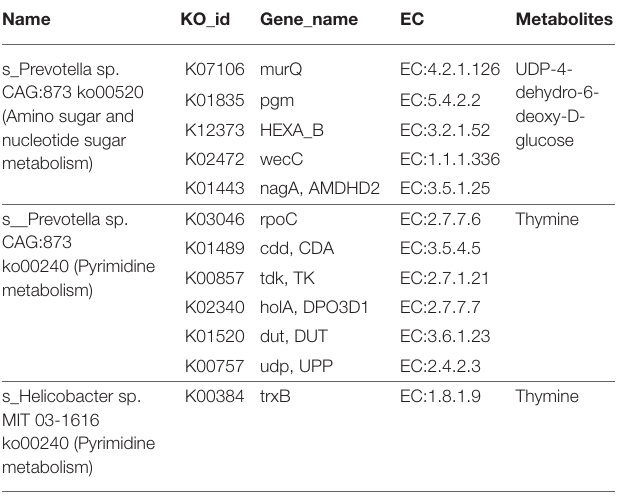
TABLE 1 | Functional annotations of associated metabolites with genes of biomarkers of ADF or ADNS mice.